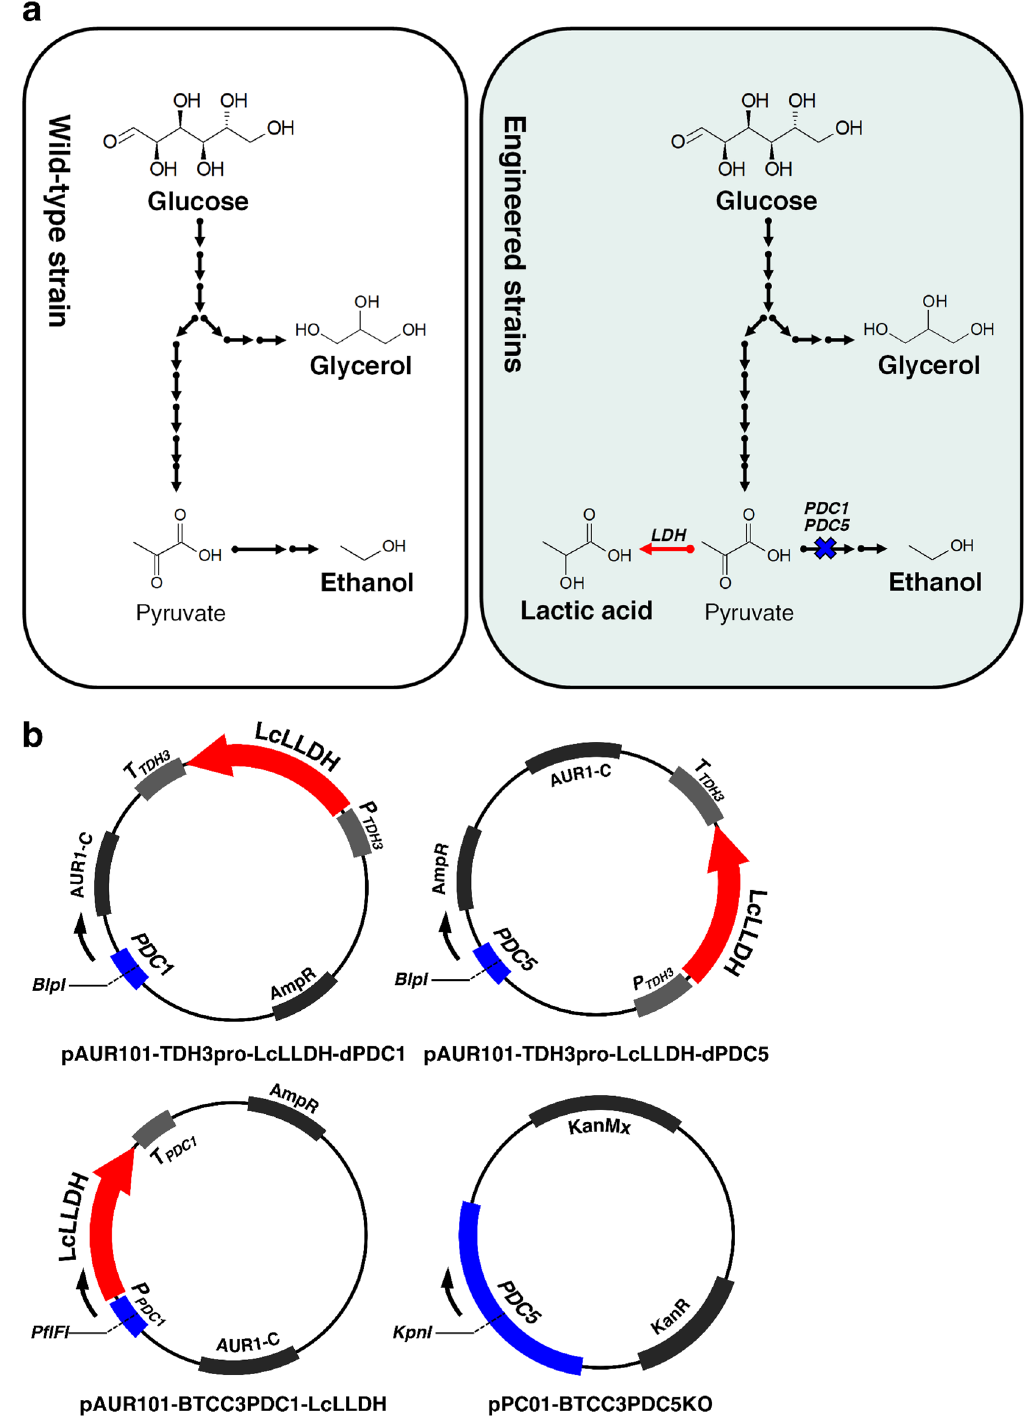
Figure 3. Pathway engineering in Saccharomyces cerevisiae BTCC3 by introducing an exogenous LDH gene to enable lactic acid generation and disrupting PDC1/5 genes to reduce metabolic flux to ethanol ( a ) using genome-integrative plasmids shown ( b ). BlpI , PflFI and KpnI indicate restriction enzymes used to digest the plasmids. Blue regions indicate the overlapping sequence of PDC 1/5 genes to the